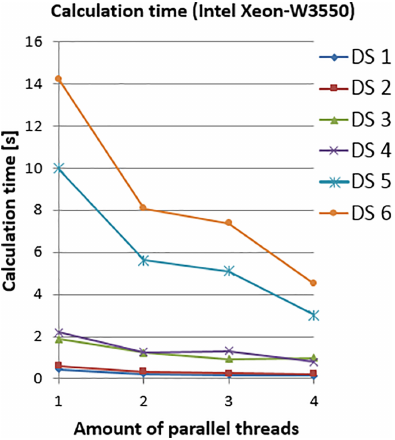
cases. For d = − 1, − 0.8, − 0.4 and d = 1 the SQP method